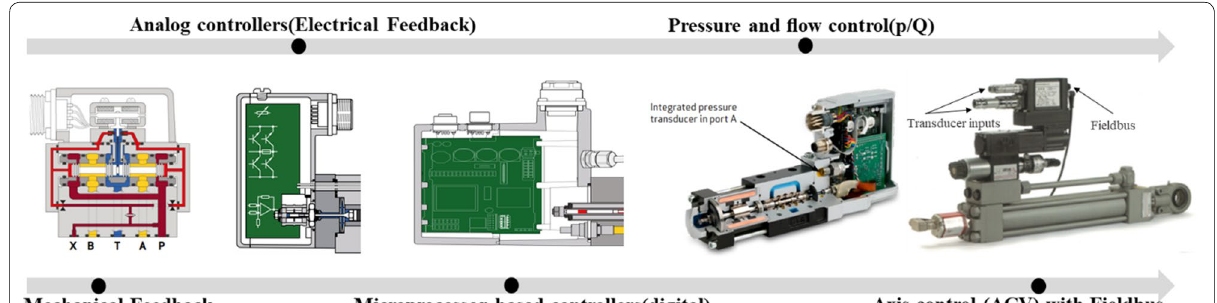
Figure 5 Development of electronic